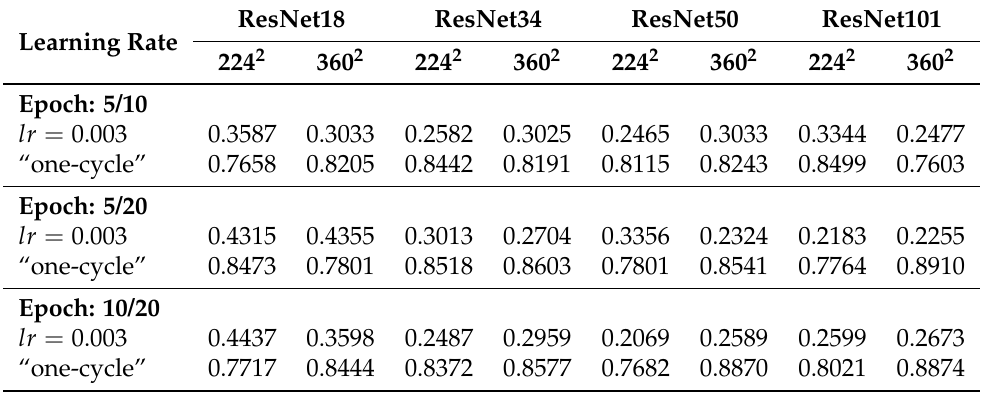
Table A1. F1 Score of different ResNet with and without discriminative learning rate scheduling on